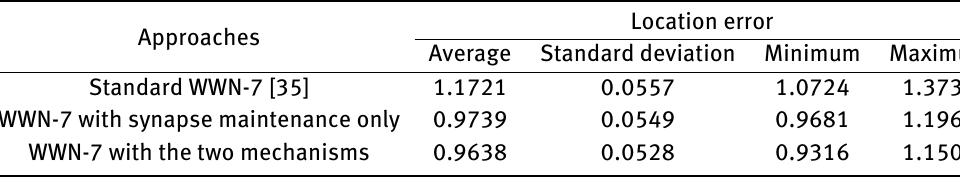
Table 7: Comparison of error on location between our work and the standard WWN-7 [35]